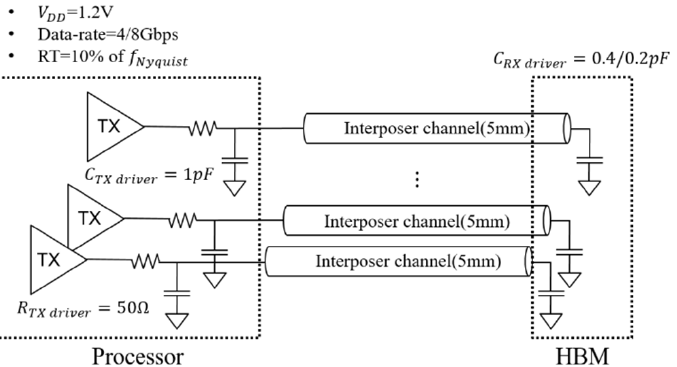
Figure 14. Eye-diagram simulation setup.